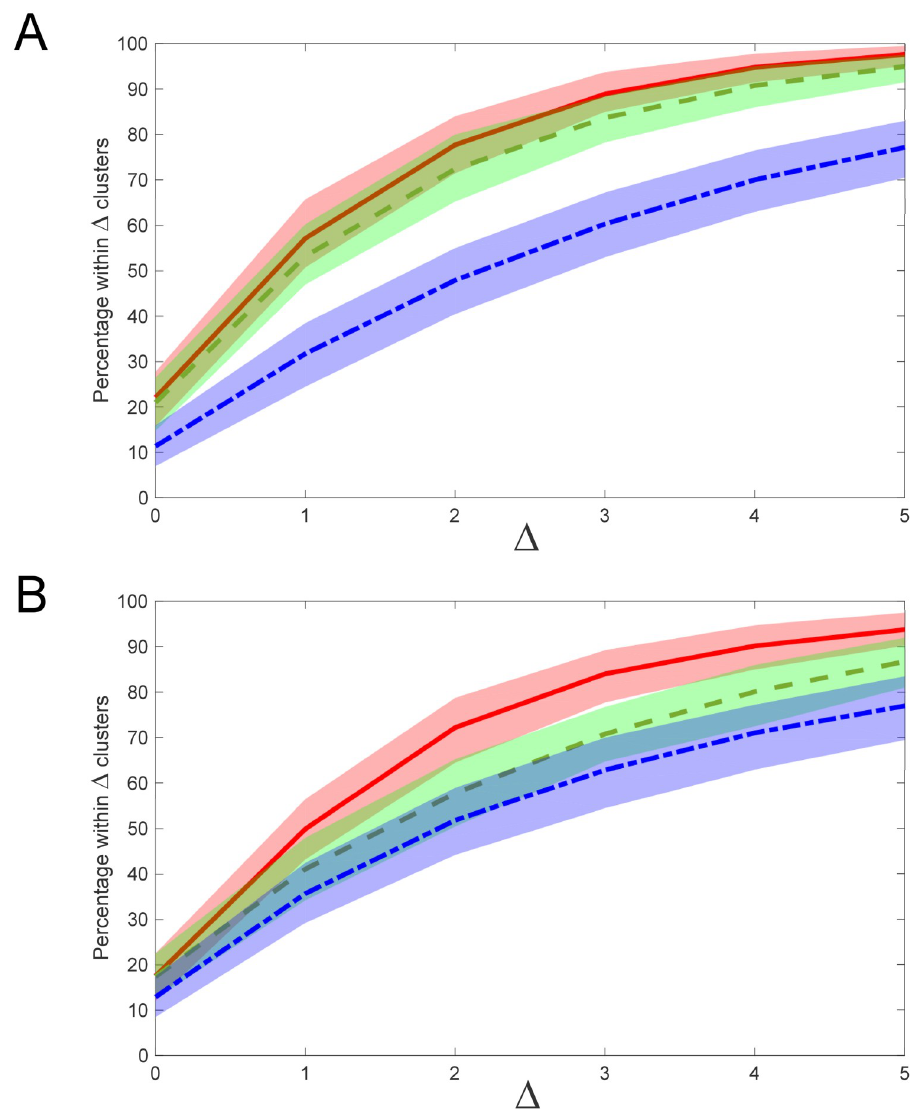
Fig 13. Effect of histogram partitioning ( R ) on model performance. (A) Image data results; (B) Text data results. Colour shaded regions represent 95% confidence interval with respect to mean percentage of model estimates lying within Δ clusters of the true cluster number (corresponding coloured line). Legend: solid RED, R = 40; segmented GREEN, R = 20; short-long segmented BLUE, R = 10. Distance metric: L1 norm; embedding dimension d